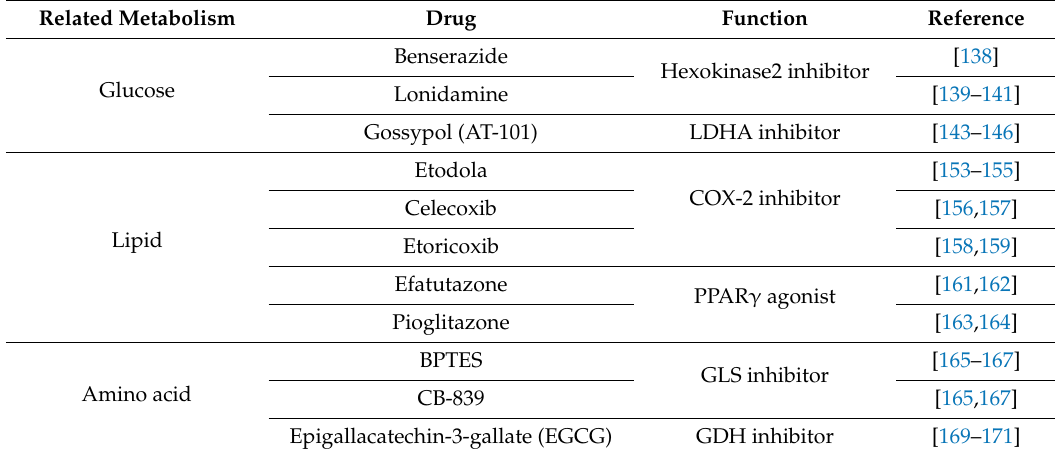
Table 1. List of metabolic regulators with clinical significance for anti-cancer